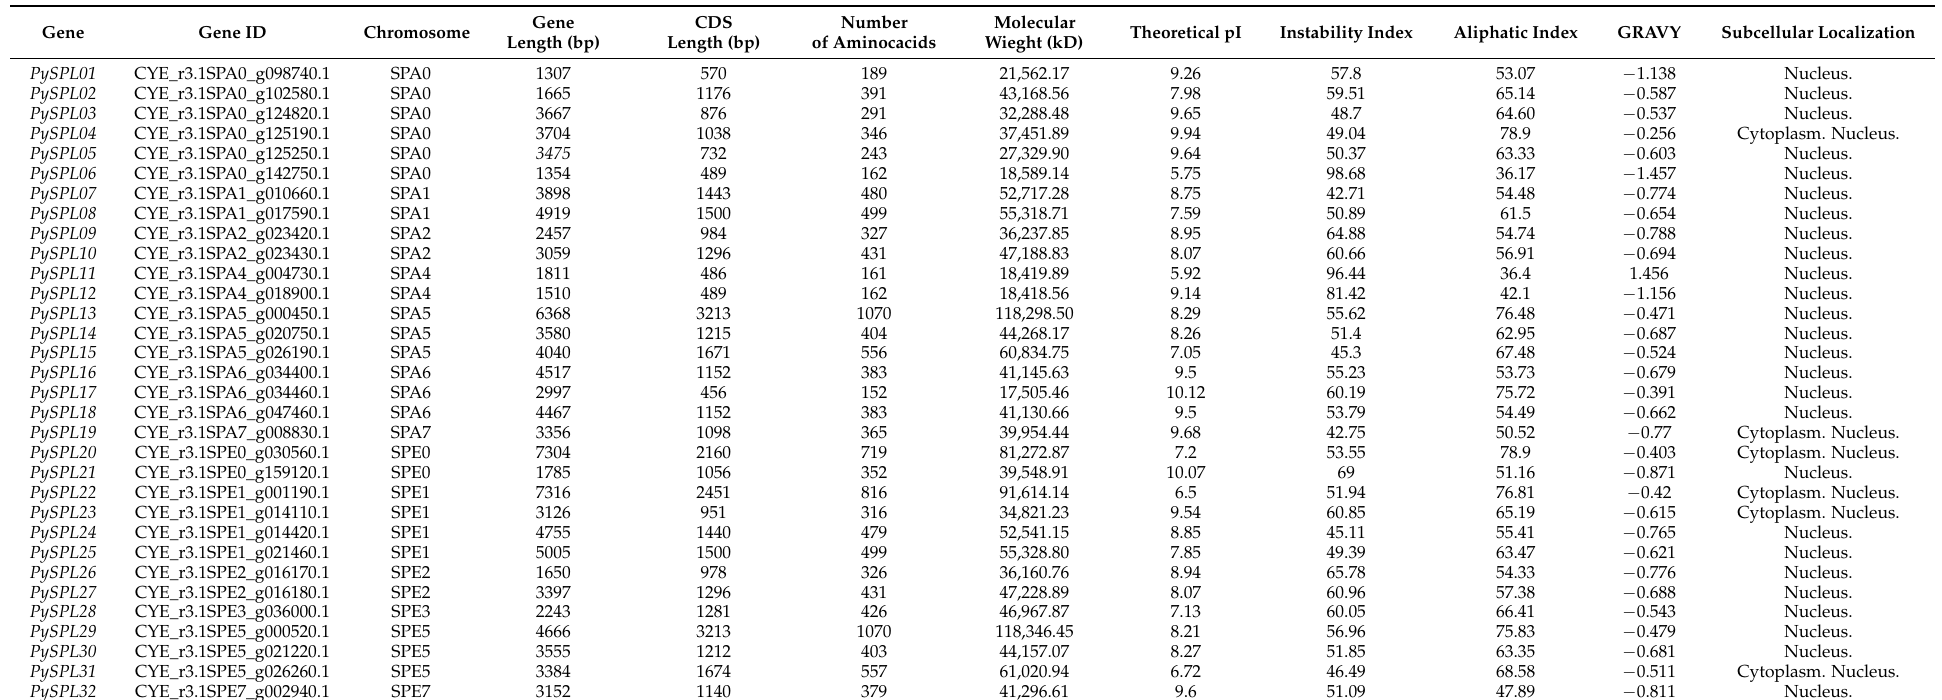
Table 1. Characteristics properties of PySPL in Prunus × yedoensis